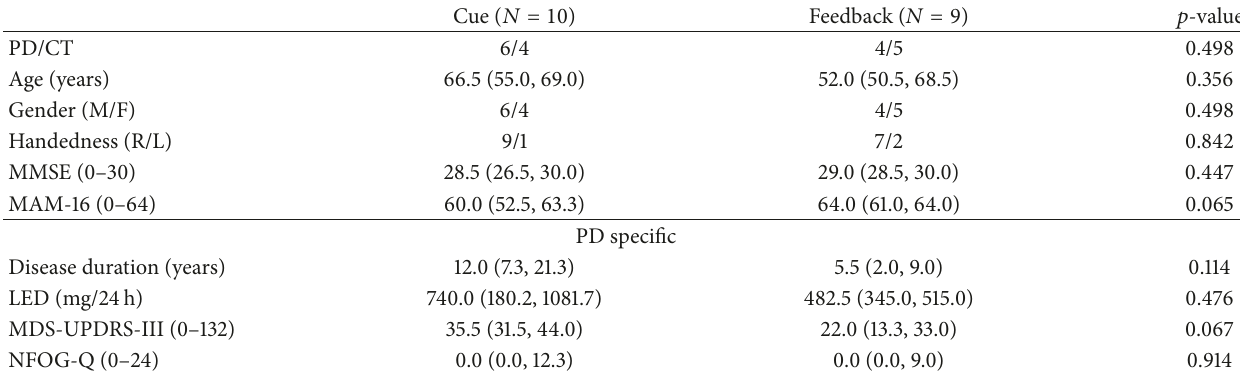
Table 1: General characteristics: median and interquartile ranges are